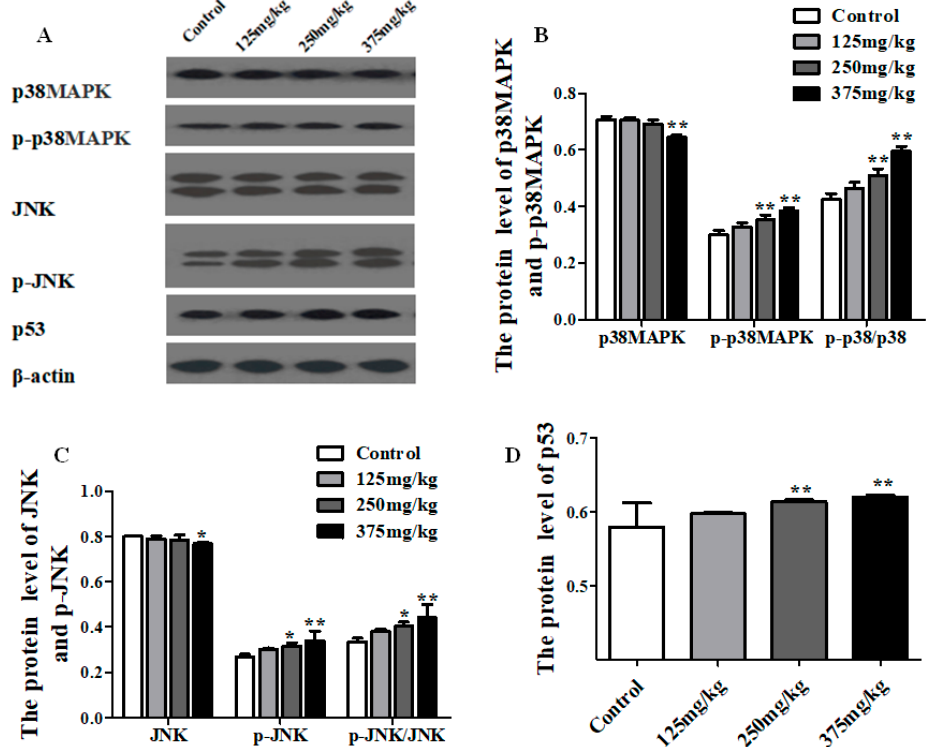
Figure 6. Effect of DEHP exposure on the total protein and phosphorylated protein expression of JNK/p38MAPK/p53 pathway in liver of mice ( n = 3). ( A ) Protein bands from the experiment of Western blot; ( B ) The total protein and phosphorylated protein expression of p38MAPK; ( C ) The total protein and phosphorylated protein expression of JNK; ( D ) The total protein expression of p53. Data represented as means ± SD, * p < 0.05, ** p < 0.01 compared with the control